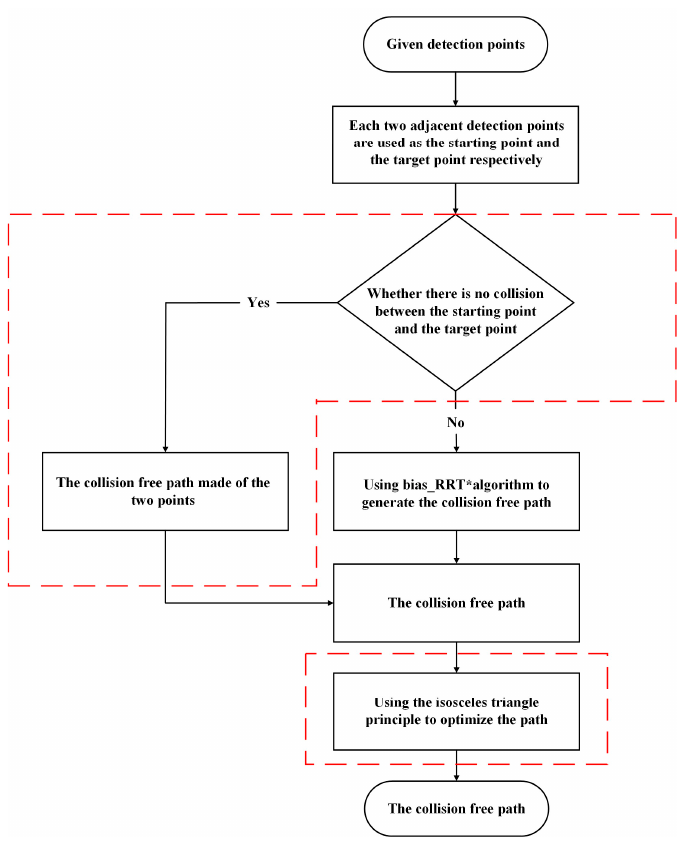
Figure 4. Flow chart of UAV trajectory optimization.